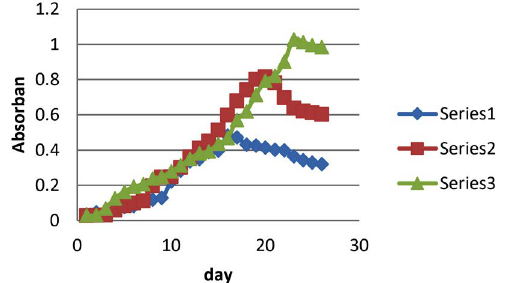
Fig. 4. Graphic of the MA1 microalgae growth curve by using Growmore fertilizer G32% (32-10-10), commercial fertilizer P5 (40 mg/L Urea; 10 mg/L ZA; 40 mg/L TSP) and BBM (Bold’s Basal Medium)